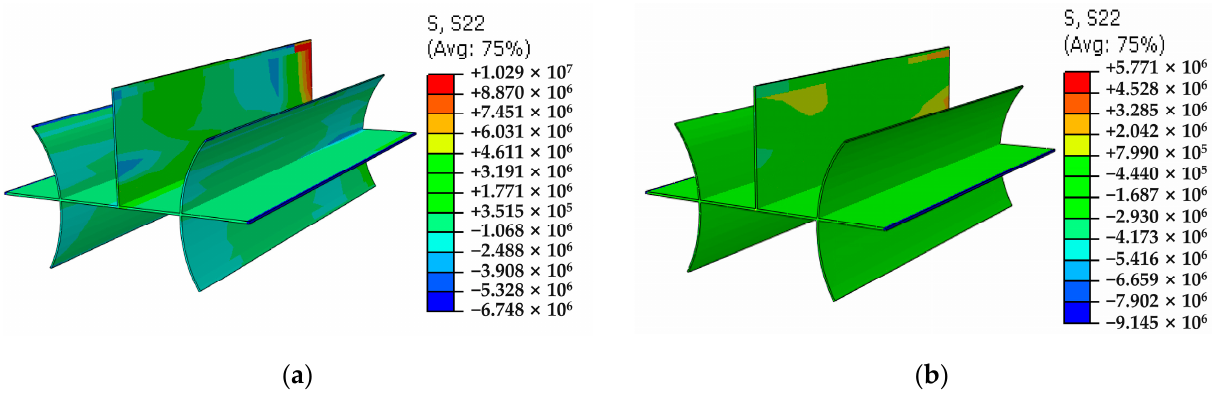
Figure 18. The vertical stress of the temporary support in different conditions (unit: Pa): ( a ) Condition 1 and ( b ) Condition